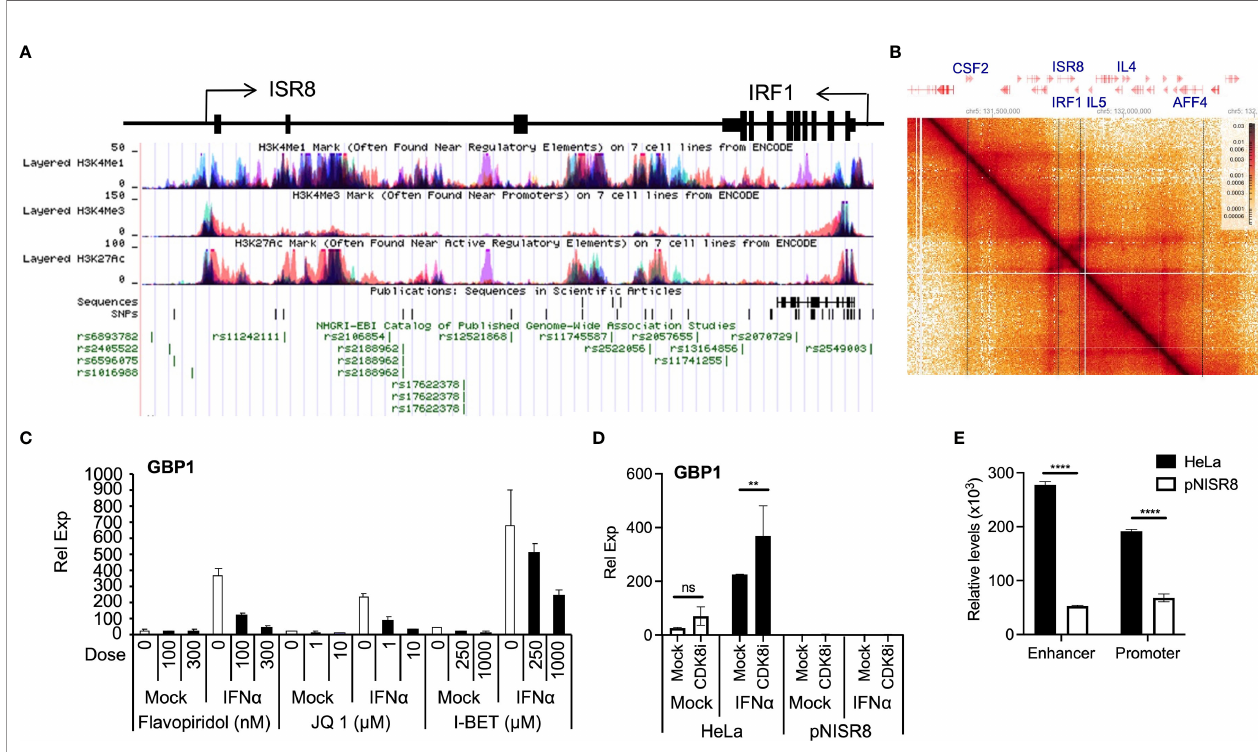
FIGURE 7 | Analysis of enhancer function in IFN a -treated cells. (A) Schematic of ISR8 locus from UCSC showing ISR8 and IRF1 genomic region, transcription, enrichment of H3K27ac, H3K4me1 and H3K4me3 marks and SNPs (https://genome.ucsc.edu/). (B) HiC image showing the interactions observed around the ISR8 and IRF1 genomic region obtained by HiGlass. Representative genes are highlighted at the top and intermittent lines are used to mark their position in the image. (C, D) . The indicated cells were mock-treated or treated with JQ1, fl avopiridol, I-BET1 (C) or the CDK8 inhibitor CCT251545 (D) . Then, 0 or 1000U/ml of IFN a were added for 6h and GBP1 mRNA levels were measured by qRT-PCR. GAPDH mRNA was also evaluated and used as a reference. Experiments were performed at least twice and a representative fi gure is shown. (E) FAIRE was performed with HeLa and pNISR8 cells and chromatin accessibility was evaluated at the ISR8 enhancer and promoter regions with high H3K4me1 levels. The experiment was performed twice and the average of the results is shown. Error bars indicate standard deviations. Statistical signi fi cance is shown where